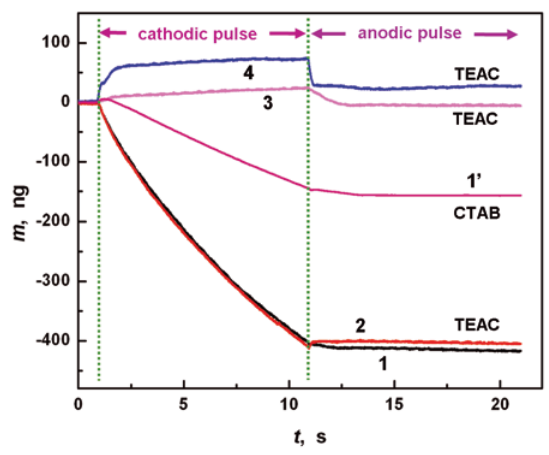
Figure 6. (a) Current (1) and mass transients (2) for potential = -0.5 V 1 film in: (1’) 10 mM CTAB and 3-x SO solutions with x: (1) 0, 2 4